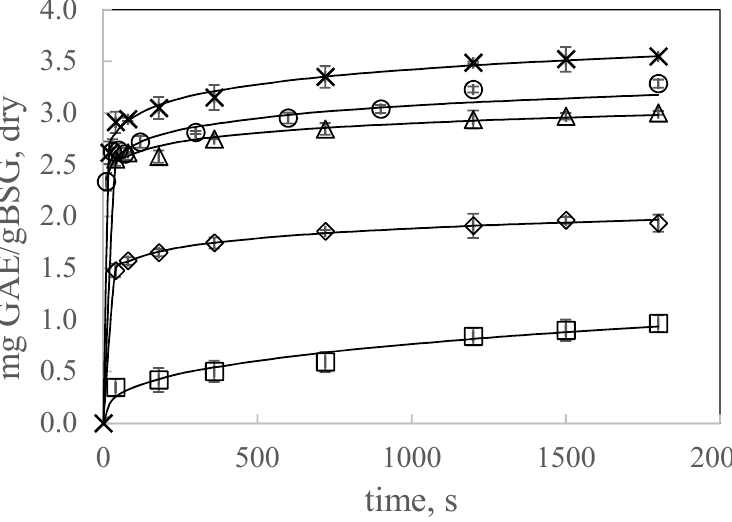
Figure 5. E ff ect of ethanol concentration on TPC extraction kinetics by UAE at 47 ◦ C and 21.7 mL: Figure 5. Effect of ethanol concentration on TPC extraction kinetics by UAE at 47 °C and 21.7 mL: g BSG,dry : water, × 20% ethanol, (cid:52) 50% ethanol, ♦ 80% ethanol, (cid:3) 100% ethanol. Continuous lines g BSG,dry : ○ water,  20% ethanol, △ 50% ethanol, ◊ 80% ethanol, □ 100% ethanol. Continuous lines (cid:35) represent the Weibull represent the Weibull model.